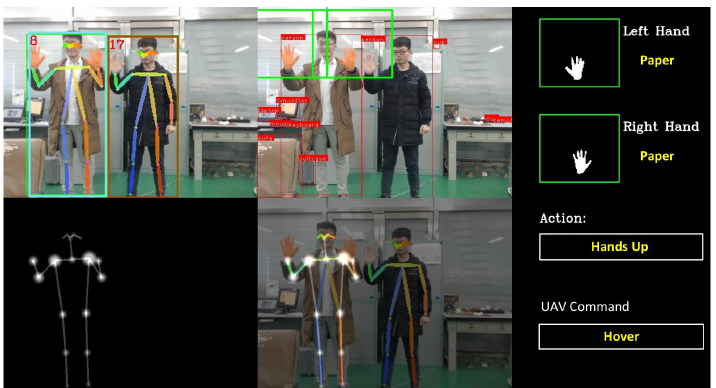
Figure 23. Simulation experimental result of our system when multiple person perform similar actions.